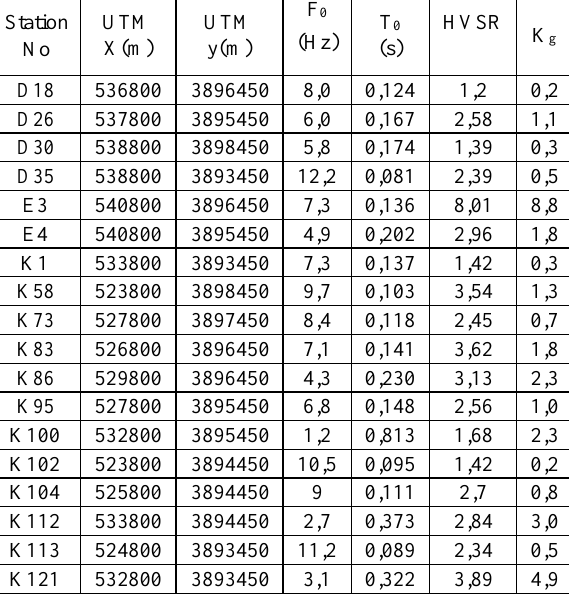
Table 1. Data catalogue which obtained from microtremor